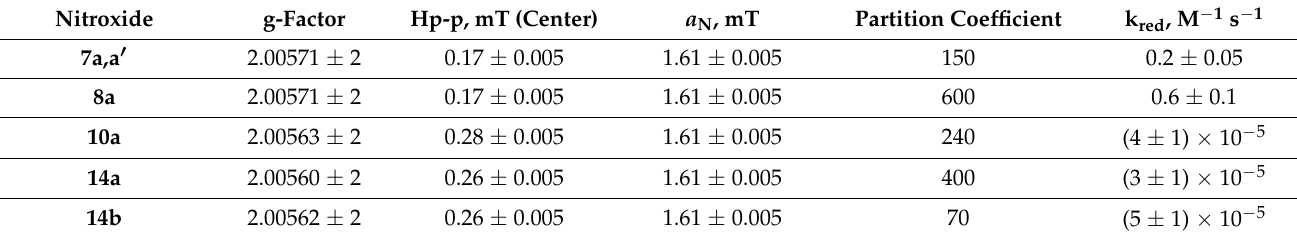
Figure 1. EPR spectra of mixtures 7a,a ′ and 8a , and individual nitroxides 10a , 14a, and 14b (0.2 mM in deoxygenated water). For spectrometer settings, see Section 3. Table 1. Parameters of EPR spectra in water, partition coefficients octanol/water, and reduction rate constants with ascorbate.